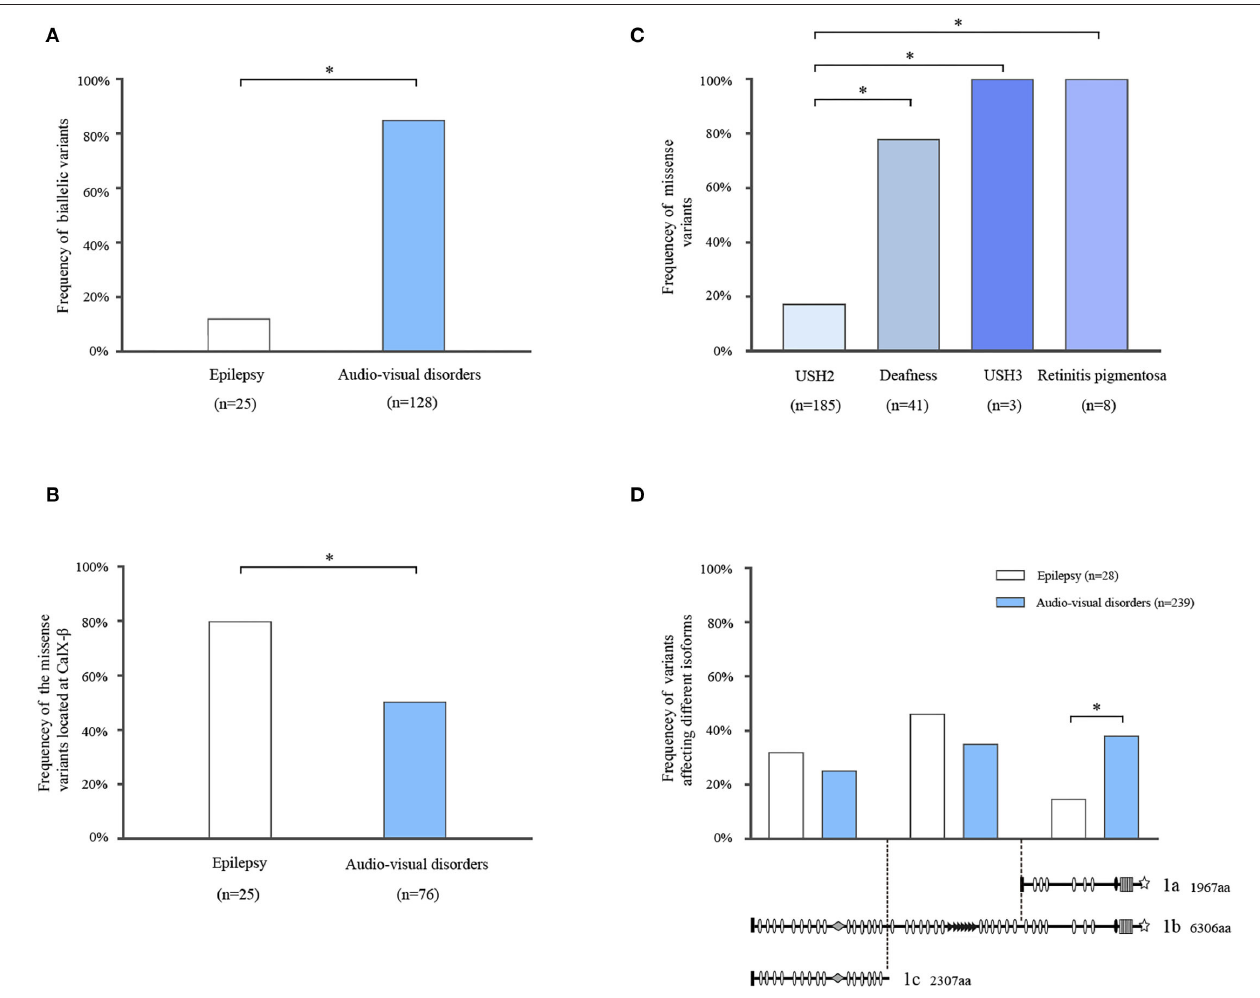
FIGURE 4 | Systematic analysis of ADGRV1 variants in epilepsy and audio-visual disorders. (A) The frequency of biallelic variants in epilepsy and audio-visual disorders. (B) The frequency of the missense variants located at the CalX- β motif in epilepsy and audio-visual disorders. (C) The frequency of missense variants in different phenotypes of audio-visual disorders. (D) The location distribution of the variants in epilepsy and audio-visual disorders. The values are expressed as the percentage of the variants located at the N-terminal segment (residues 1–2,295), central segment (residues 2,296–4,339), and C-terminal segment (residues 4,340–6,306). Fisher’s exact test and chi-square test were used for statistical analysis. *means P <